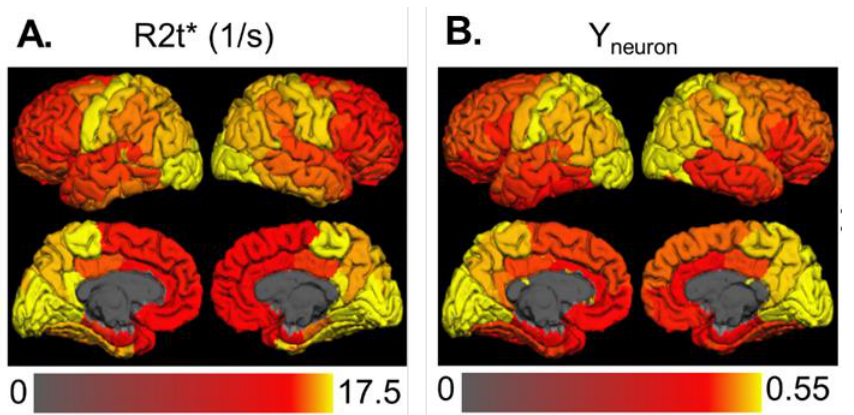
Figure A1. The association between the expression of neuron-related genetic networks across different regions of the human brain and R2t* measurements in the same regions (adapted from [26]). The R2t* map ( A ) in this figure was obtained from qGRE MRI; Yneuron ( B ; designated as the Neuronal Density Index) was obtained from the analysis of the gene expression profiles in the Allen Human Brain Atlas, including two totally independent measurements. The figure and analysis in [26] provided convincing and consistent with literature arguments that the R2t* metric of the qGRE signal is strongly associated with neuronal density.